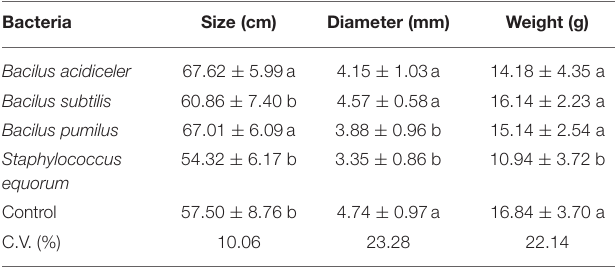
TABLE 4 | Effect of growth-promoting bacteria on size, diameter and weight of stem of roses cv. Black Prince. Bacteria